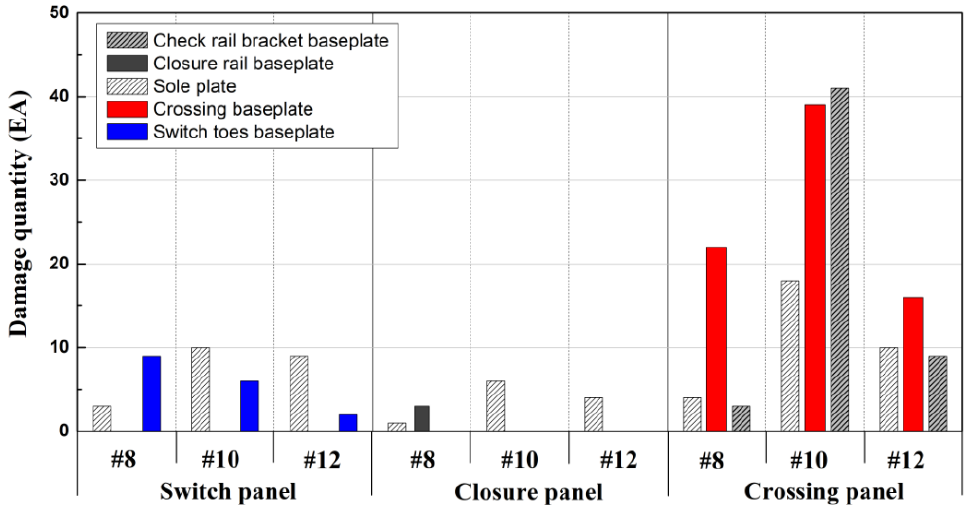
Figure 12. Damage status of baseplates.